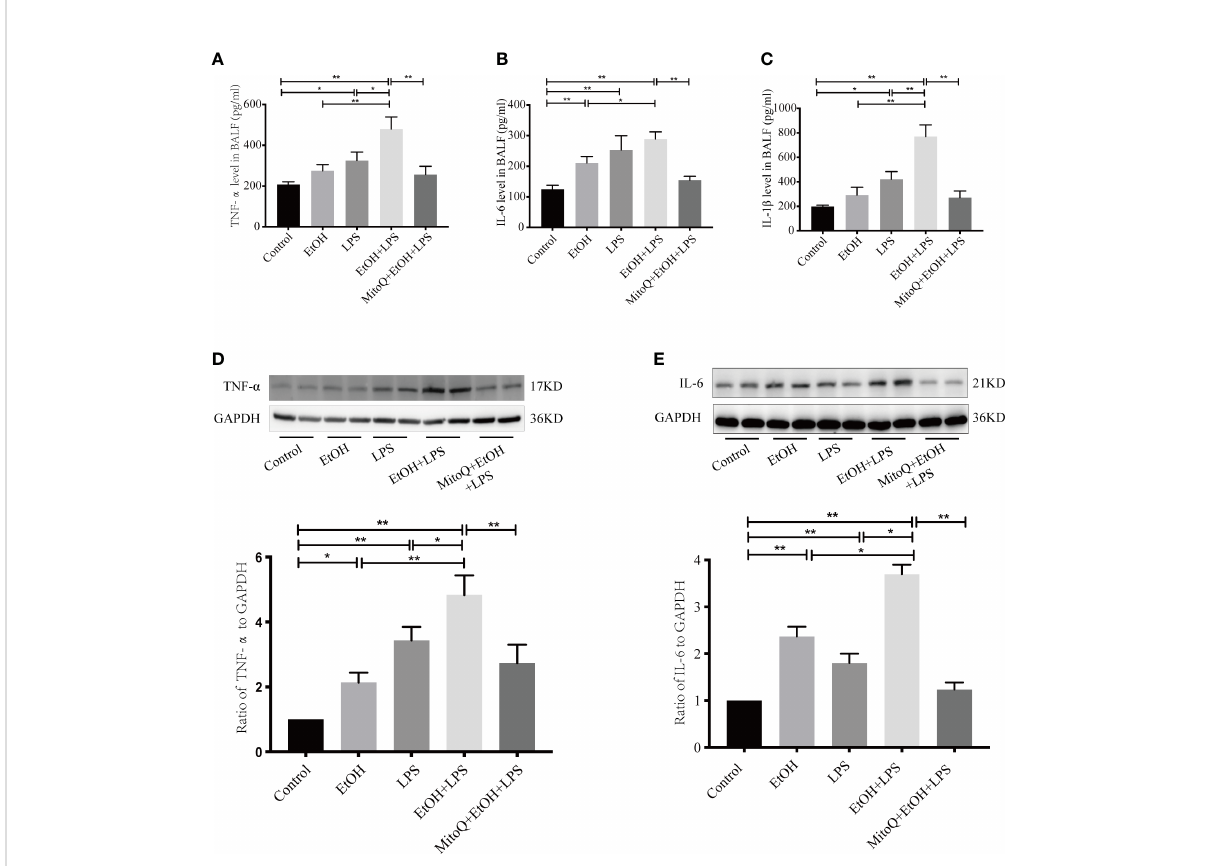
FIGURE 2 MitoQ decreased ethanol-LPS-induced pro-in fl ammatory factor production. The BALF were pooled and centrifuged (1000×g, 10 min, 4°C). The cell-free supernatant of BALF was assessed for TNF- a (A) , IL-6 (B) , and IL-1 b (C) by ELISA. The pro-in fl ammatory factor in lung tissue protein TNF- a (D) , and IL-6 (E) was measured by western blotting. All data were presented as mean ± SEM (n=6 in each group), *P < 0.05, **P <